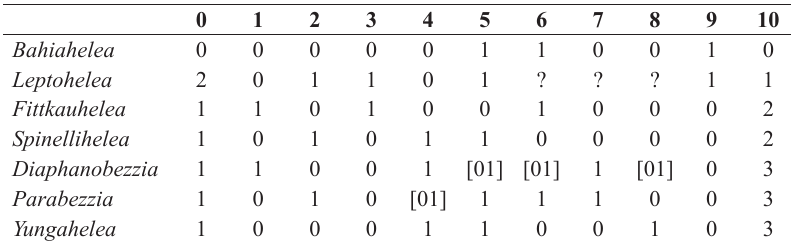
Data matrix for 7 taxa and 11 morphological characters used in the cladistic